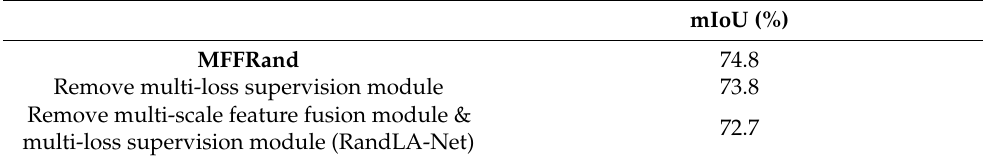
Table 4. Results of ablated network on the Semantic3D (reduced-8).